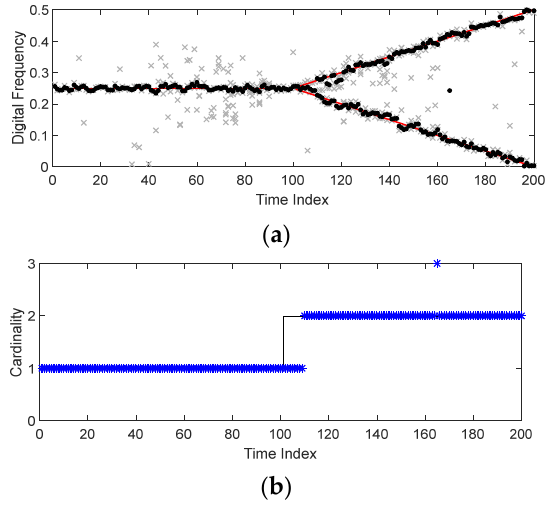
Figure 6. The result of the CC_CPHD (case 1): ( a ) Frequency tracking; ( b ) Cardinality estimate.